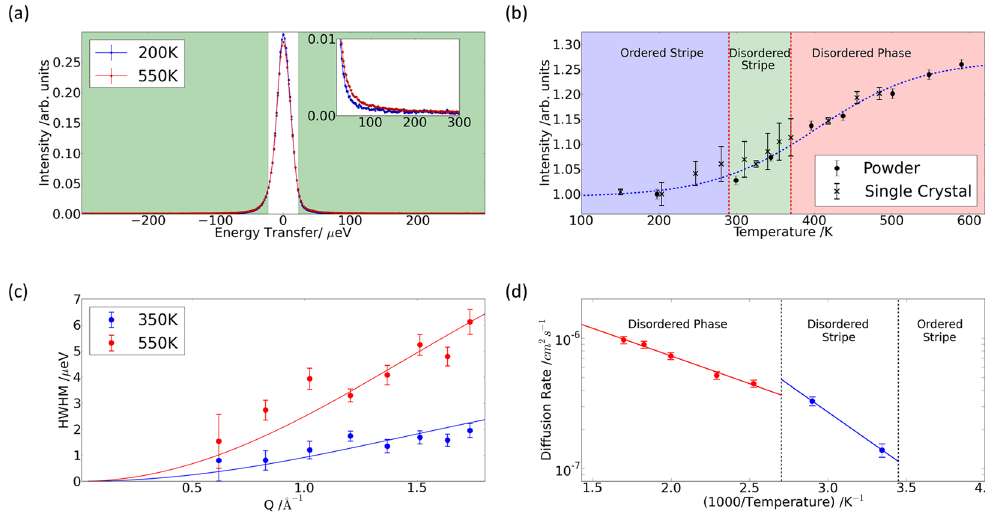
Figure 5. Quasi-elastic neutron scattering measurements of diffusion in Na 0.8 CoO 2 . ( a ) QENS spectra from Na 0.8 CoO 2 at T ~ 200 K (blue) and T ~ 550 K (red) integrated over Q . At elevated temperature there is a transfer of intensity from the elastic region near E ~ 0 meV to the wings above | E | > 22.5 µ eV (green shaded region). Inset shows increase in the quasi-elastic region. ( b ) QENS intensity integrated over Q and energy transfer as a function of temperature for the powder and single-crystal samples – the dotted line is a guide to the eye. There is an increase in QENS in the partially disordered stripe and disordered phase, and this is correlated with the onset of superionic diffusion by Na 29 . ( c ) QENS energy width as a function of Q in the fully disordered phase (red, T ~ 550 K) and the partially disordered stripe phase (blue, T ~ 350 K). Fits of the Chudley-Elliott model of jump diffusion for 2 d − 2 b hops are shown as solid lines. ( d ) Arrhenius plots of the diffusion coefficients from the fits of the Chudley-Elliott model to the QENS data in the disordered phase (red) and partially ordered stripe phase (blue) give activation energies E A ~ 85(5) meV and 170(20) meV,